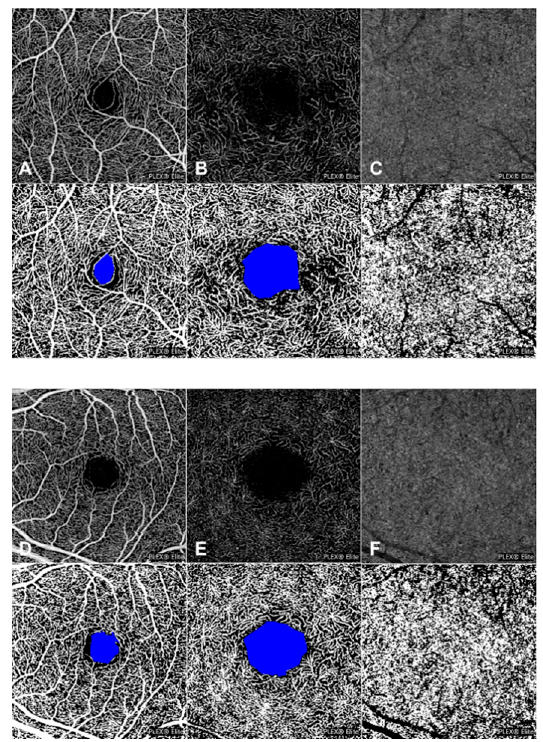
Figure 1. Optical coherence tomography angiography (OCT-A) analysis of a type 1 diabetic patient and a healthy control subject. 3 × 3 en-face OCT-A images with corresponding binarized images of superficial capillary plexus (SCP) ( A ), deep capillary plexus (DCP) ( B ), and choriocapillaris (CC) plexus ( C ) of a type 1 diabetic patient and of a healthy control subject ( D – F ). No significant differences were disclosed in the perfusion density (PD) of SCP and CC between diabetic patients ( A , C ) and controls ( D , F ), but diabetic eyes revealed a significantly decreased PD compared to the control group in the DCP ( B , E ). In the binarized image, FAZ area of SCP and DCP was colored with pure blue.